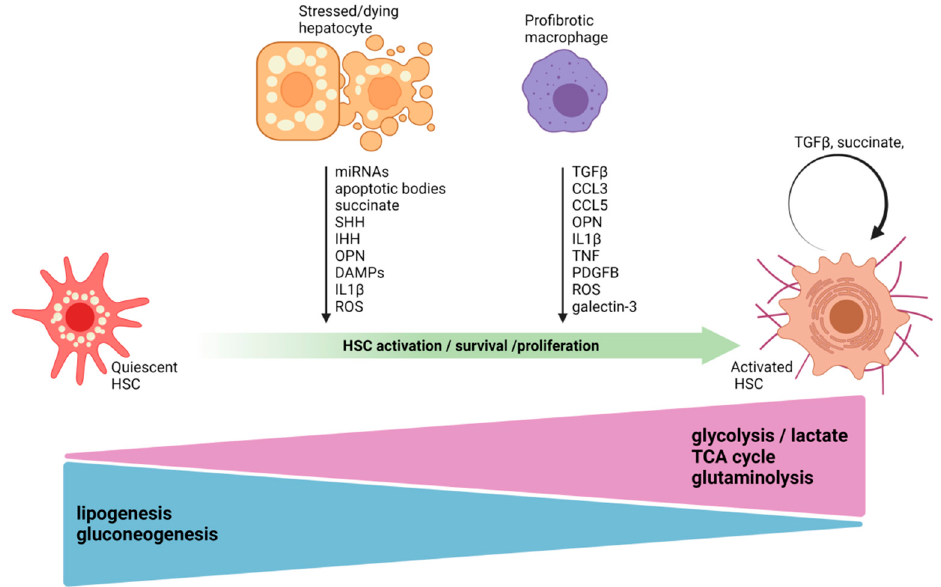
Figure 1. Cellular crosstalk in the context of HSC activation during NASH, based on mouse models. Quiescent HSCs in normal liver contain retinoid-rich lipid droplets and exhibit high levels of lipogenesis and gluconeogenesis. During NASH, stressed hepatocytes and macrophages can activate HSCs, which then transdifferentiate into ECM-producing, highly proliferative MFBs and contribute to hepatic fibrosis development. The lipogenesis and gluconeogenesis metabolic pathways are downregulated in activated MFBs, whereas, glycolysis, the TCA cycle and glutaminolysis are upregulated. Higher glycolysis leads to enhanced intracellular lactate accumulation, which further propagates the profibrogenic reprogramming of HSC gene expression. Stressed or dying hepatocytes and liver macrophages promote HSC activation, survival and proliferation by secreting a wide range of molecules, which include cytokines, chemokines, miRNAs, ROS, DAMPs, metabolites and apoptotic bodies. miRNA, microRNA; SHH, sonic hedgehog; IHH, Indian hedgehog; OPN, osteopontin; DAMP, damage-associated molecular patterns; ROS, reactive oxygen species; TGF β , transforming growth factor- β ; CCL3, chemokine (C-C Motif) Ligand 3; CCL5, chemokine (C-C motif) ligand 5; TNF, tumor necrosis factor; PDGFB, platelet-derived growth factor; IL1 β , interleukin 1 beta. Figure was created using BioRender.com .